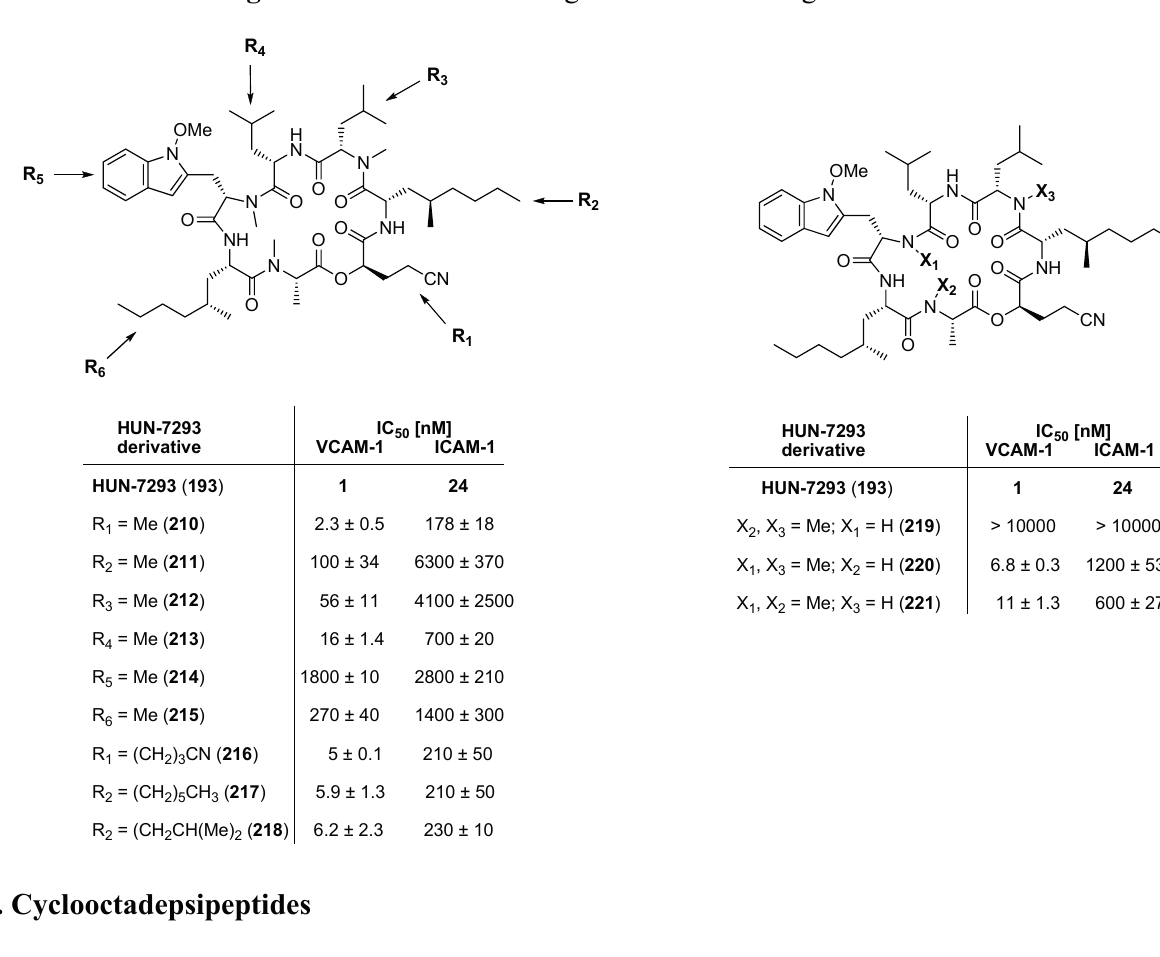
Figure 22. HUN-7293 analogues and their biological activities.